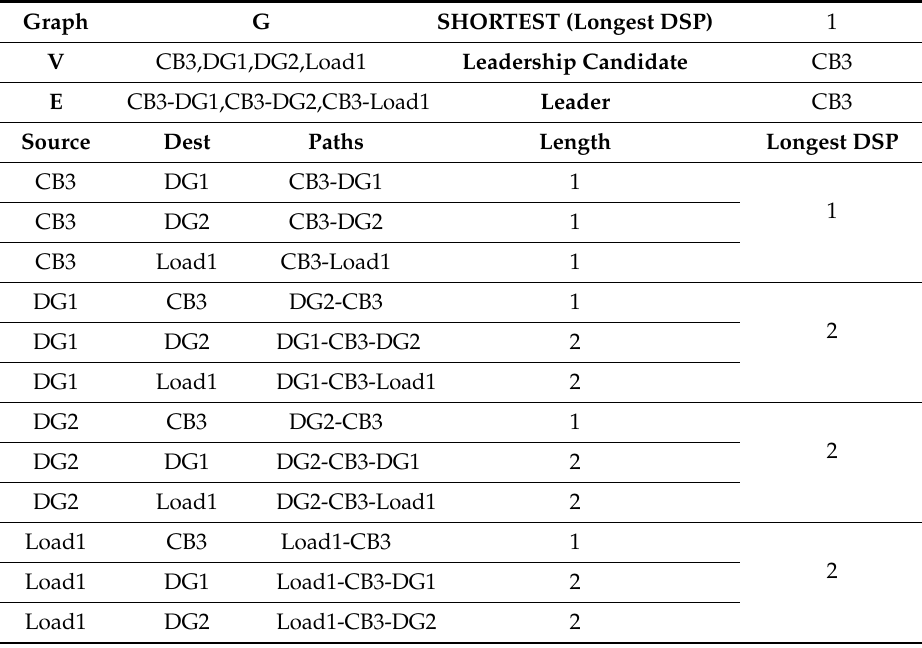
Table 4. Application of update algorithm on